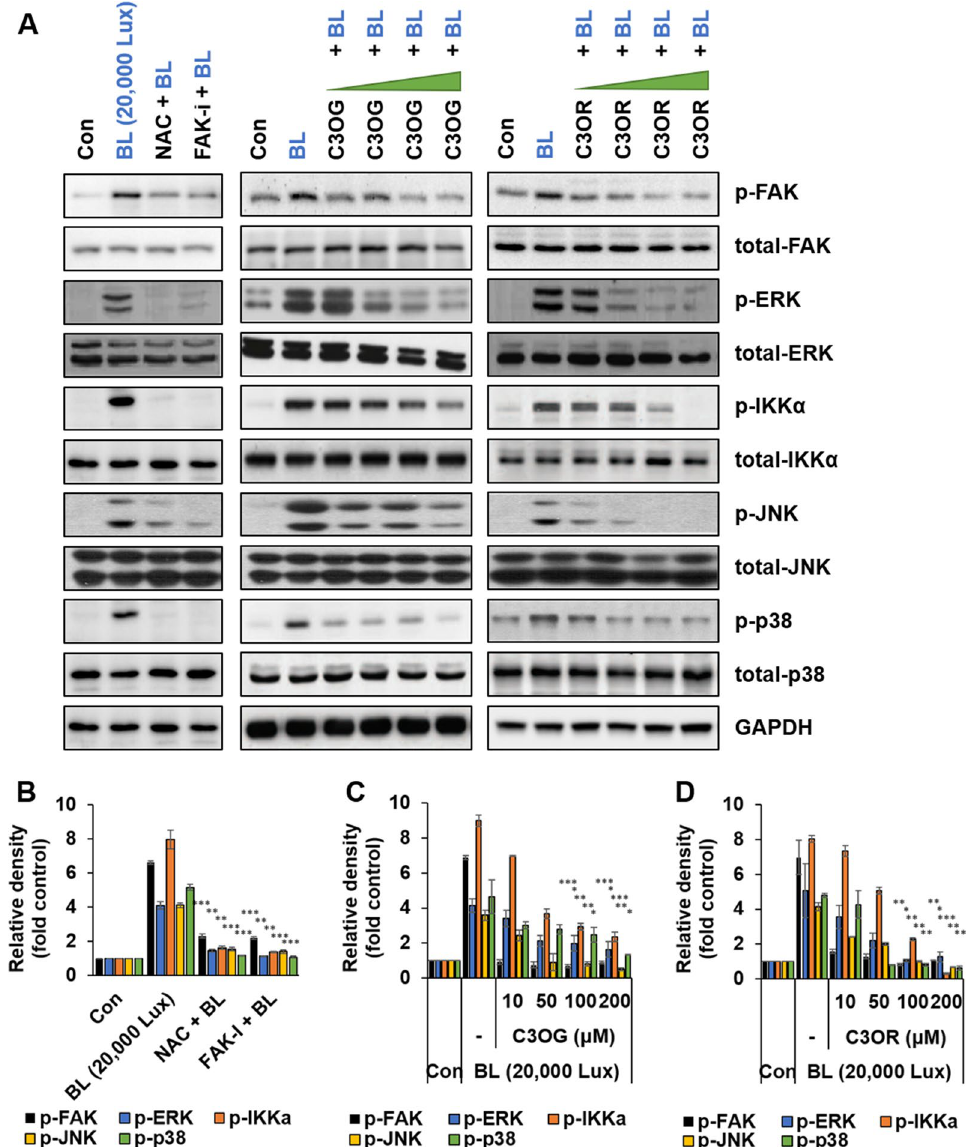
Fig. 3 Effects of C3OG and C3OR on the activation of FAK and MAPK induced by blue light. HaCaT cells in six‑well plates were exposed to blue light (20,000 lx) for 30 min. Cells were pre‑treated with or without NAC (10 mM) and FAK‑i (1 µM) for 1 h or different concentrations (10, 50, 100, or 200 µM) of C3OG or C3OR for 24 h prior to blue light exposure ( A ). Immunoblots show pY397 FAK, p‑IKKα, p‑JNK, p‑ERK, and p‑p38, the corresponding total proteins, and GAPDH used as a loading control. B–D Calculated fold changes in pY397 FAK, p‑IKKα, p‑JNK, p‑ERK, and p‑p38 ( n p < 0.05, ** p < 0.01, and *** p < 0.001 vs. blue light (20,000